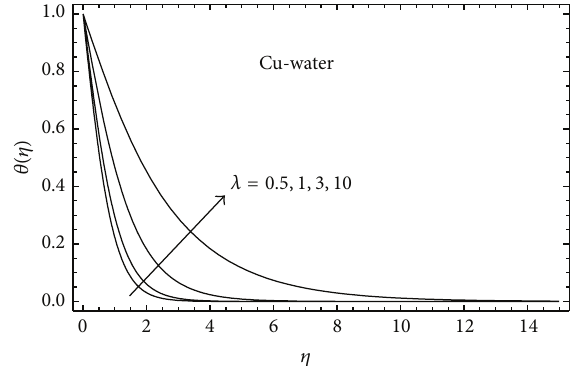
Figure 7: Effect of 𝜆 on temperature distribution 𝜃(𝜂) for Pr = 6.2 and 𝑀 = 1 .